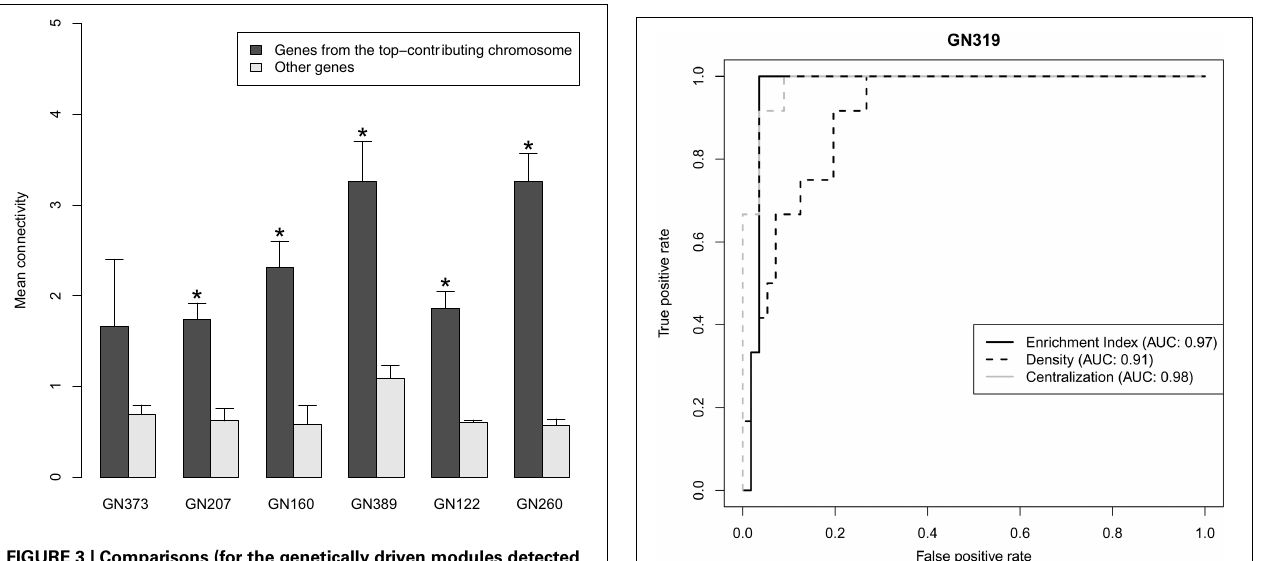
FIGURE 3 | Comparisons (for the genetically driven modules detected in the 6 tested discovery datasets) of the mean connectivity values of genes originating from the top-contributing chromosome vs. that of other genes in the modules. The bars represent mean ± SD. ∗ P < 0 . 05 (Wilcoxon Signed Rank test).